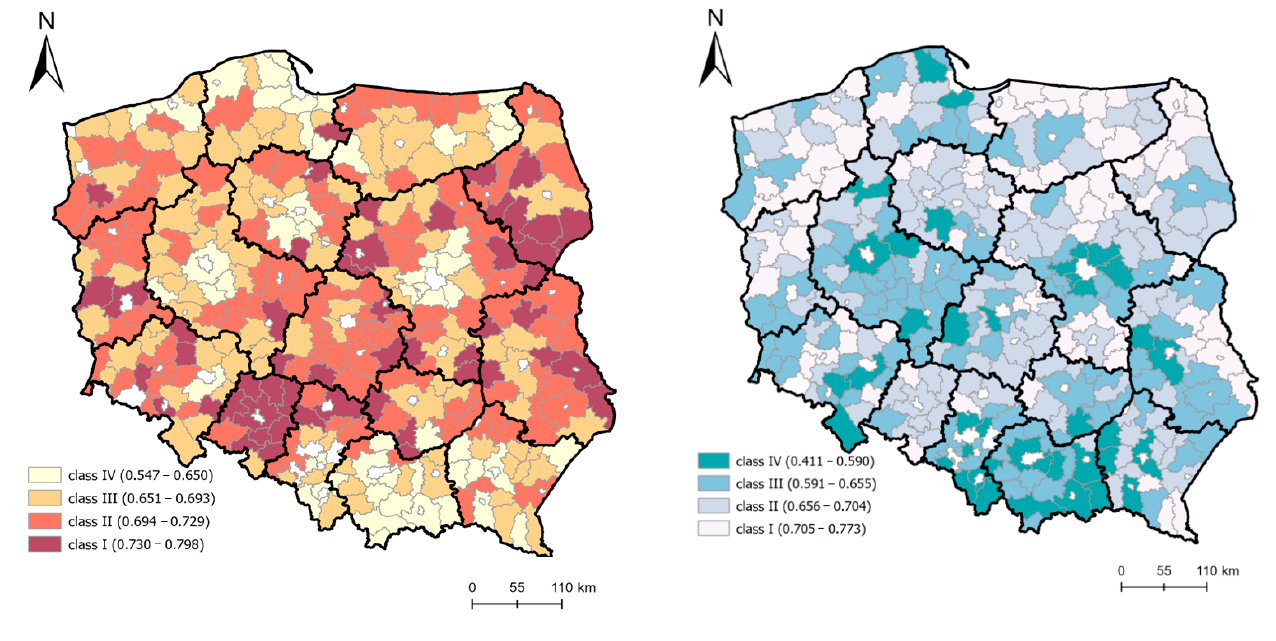
Figure 5. Spatial delimitation of intended and unintended interpersonal relations. Source: own elaboration.